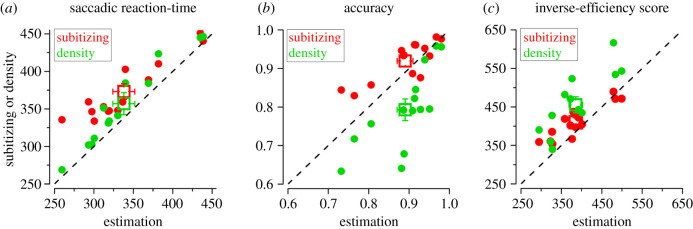
Individual results. Saccadic reaction-time for the correct responses (a, ms), accuracy (b, proportion correct), and inverse-efficiency score (c, ms) measured in the subitizing (red) and density (green) ranges (on the ordinate) plotted against those in the estimation range (on the abscissa). Individual participants are shown in circles, squares show the mean ± standard error of the mean (n = 14).